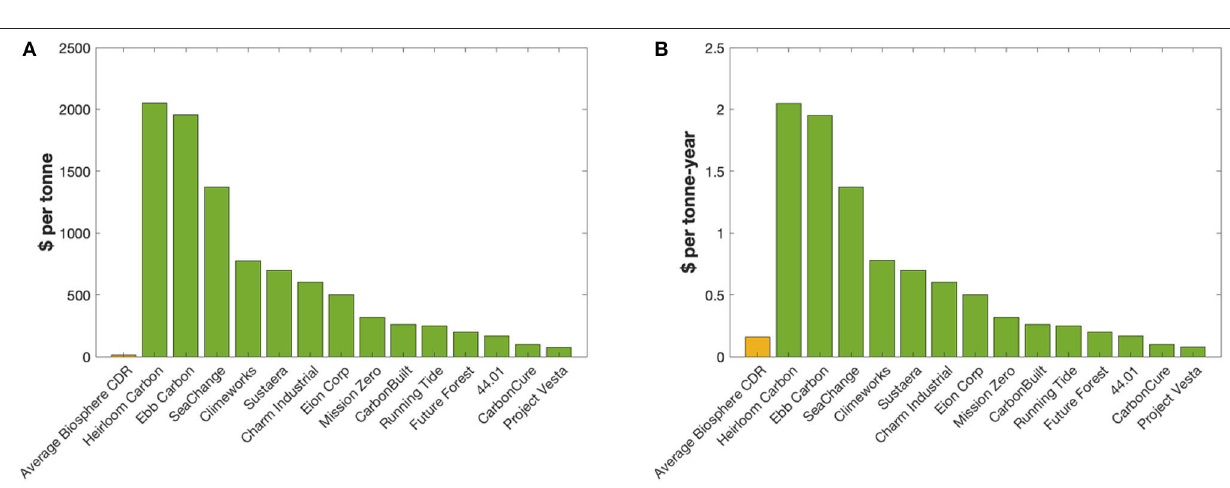
Frontiers in Climate |